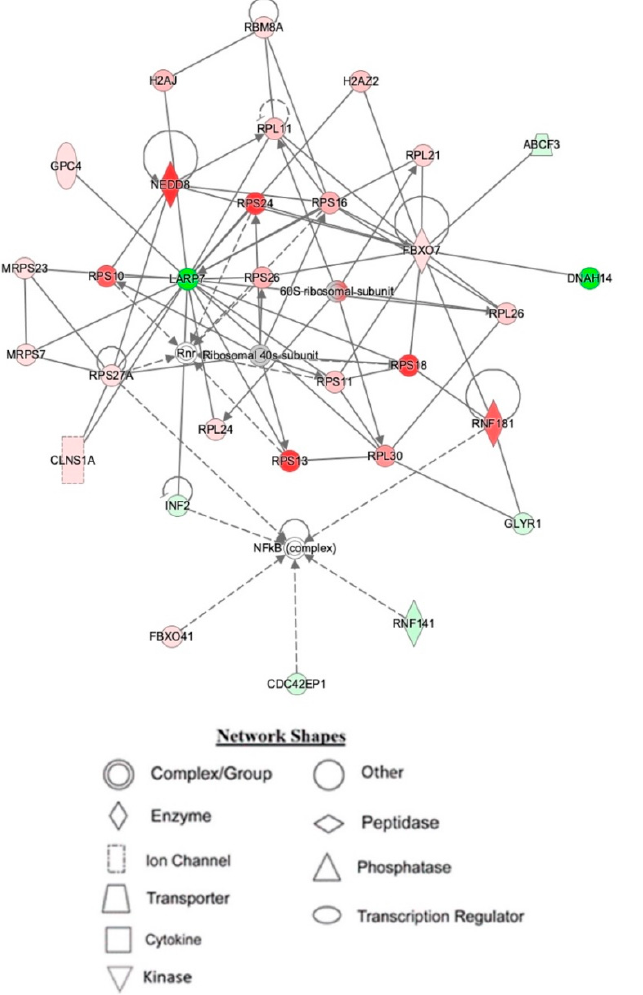
Figure 3. Depiction of mouse hippocampal network 1, affected by IPA resulting from TAC treatment. Node color is indicative of differential expression. Red represents upregulation, and green represents downregulation. Color intensity directly corresponds to the degree of regulation. Gray nodes represent proteins found in the data set but were not significantly expressed. Uncolored nodes represent proteins not differentially expressed but were incorporated into the computational network based on evidence stored in the Ingenuity Knowledge Base. The arrows and blocked lines indicate known direct and indirect interaction as well as the direction of the interaction. Table 4. Top 5 canonical pathways affected by TAC treatment, as highlighted by IPA. Pathway Name p -Value